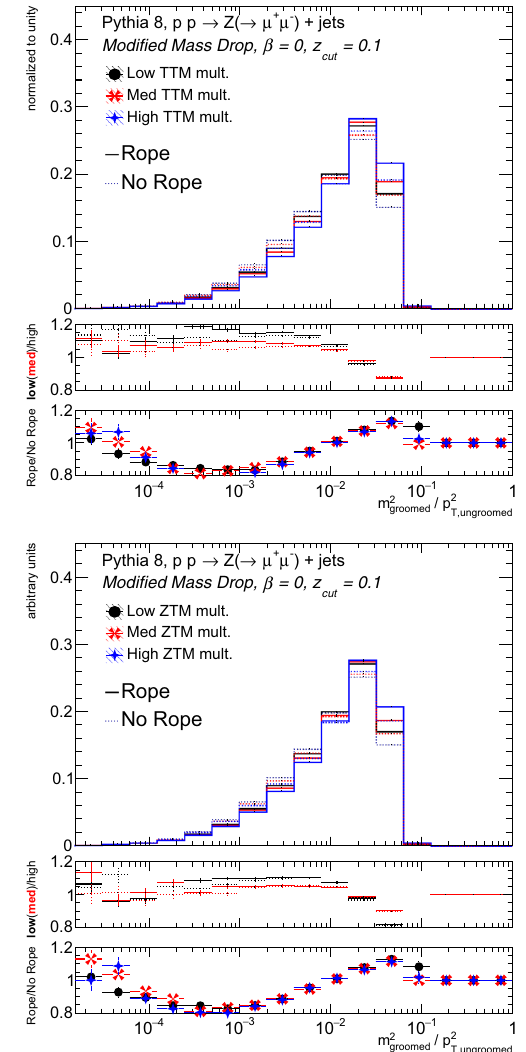
Fig. 20 Modified Mass Drop (also Soft Drop with β = 0) jet mass (left) and momentum sharing z g (right) for three bins in FM that corre- spond to the 50th, 75, and 90th percentiles. The middle panel shows the ratio of the distributions for high to low multiplicity for both hadroniza- tion models (standard hadronization with a dotted line). In the lower